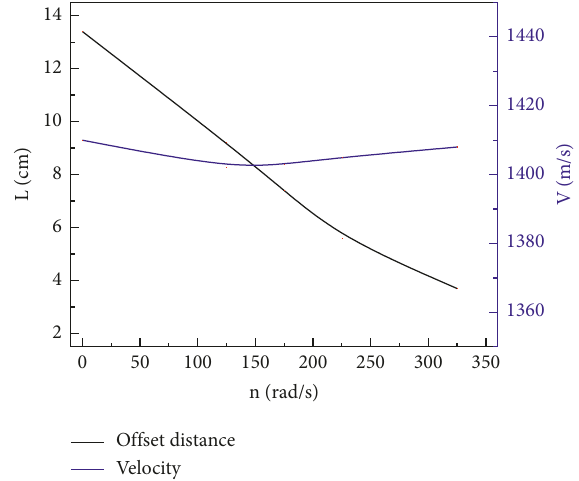
Figure 17: Relationship between the angular velocity and the landing accuracy.